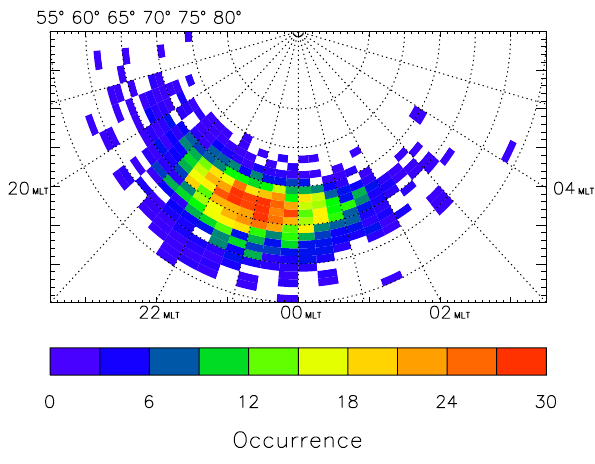
Fig. 1. The locations of Northern Hemisphere isolated substorm on- sets, observed by the FUV instrument on-board the IMAGE satel- lite, presented in magnetic latitude – magnetic local time coordi- nates. The occurrence of substorms within each latitude – local time bin is colour coded according to the scale at the